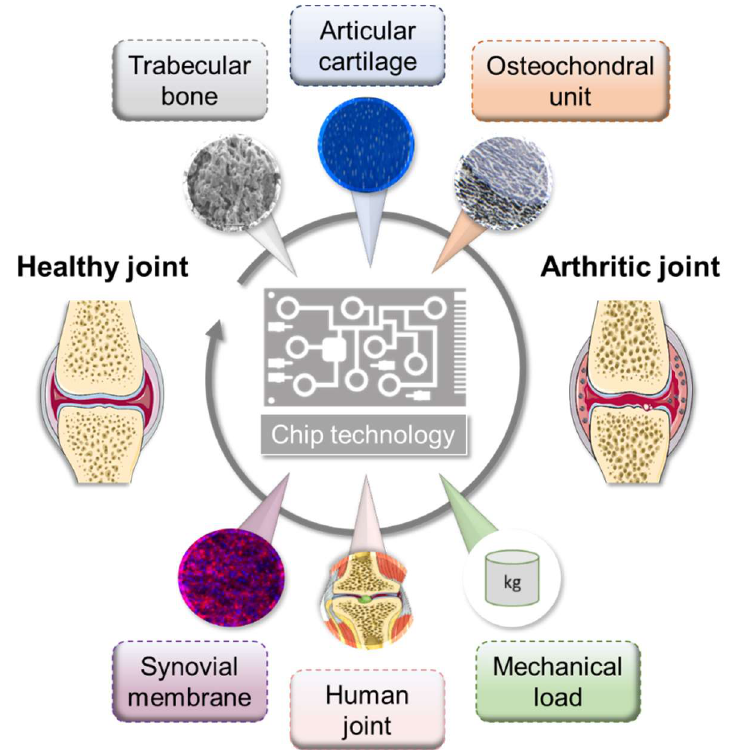
Figure 3. Overview of microfluidic approaches mimicking selected physiological interactions of the human joint tissues. Figure was modified from Servier Medical Art, licensed under a Creative Common Attribution 3.0 Generic License. http://smart.servier.com/.